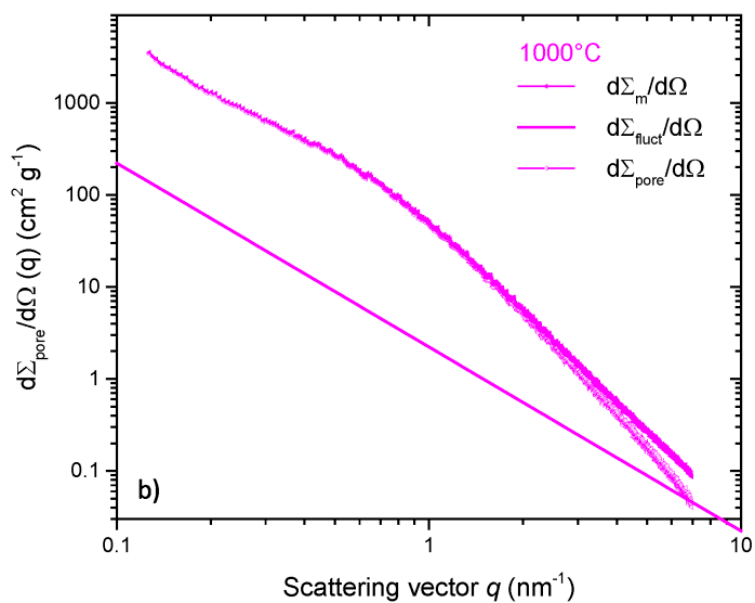
Figure 3. Analysis of CDC-carbon materials by SAXS using the CLD-approach [75]. The scattering curves (mass normalized) for two CDC powder synthesized at 600 °C ( a ) or 1000 °C ( b ) are given as filled symbols, and the fluctuation contribution Equation (4) from the lateral imperfection and finite size of the carbon layers is indicated by solid lines in the graphs. Removal of the scattering contribution caused by these fluctuations allow us to analyze the scattering intensity for porosity, given as open symbols. See text for further explanation. Reproduced with permission from [75] copyright © 2019, Elsevier.